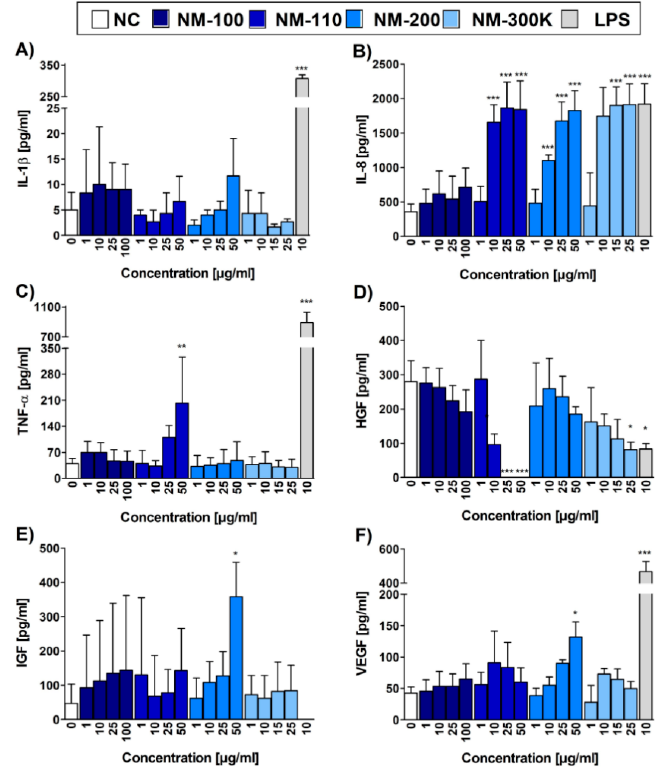
Figure 5. Cytokine, chemokine and growth factor levels evaluated by ELISA. Bar plots represent concentrations of IL-1 β ( A ), IL-8 ( B ), TNF- α ( C ), HGF ( D ), IGF-1 ( E ), and VEGF ( F ) in CCM upon 24-h exposure. Three independent experiments were performed. Data are expressed as mean ± SD.